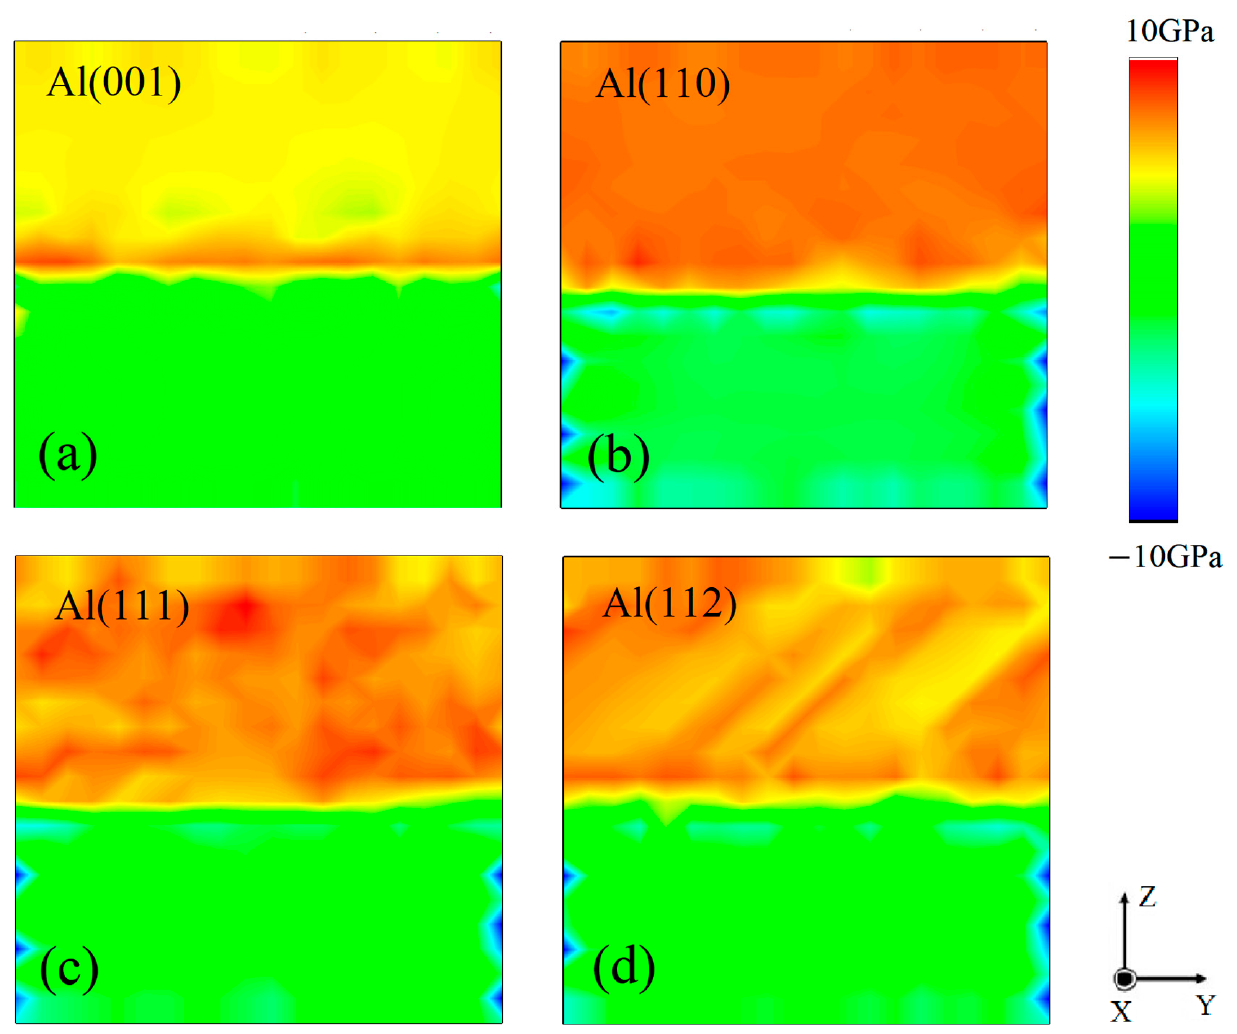
Figure 5. Stress distribution before cracks’ nucleation of four SiC(0001)-Si/Al interface systems: ( a ) SiC(0001)-Si/Al(001), ( b ) SiC(0001)-Si/Al(110), ( c ) SiC(0001)-Si/Al(111), ( d ) SiC(0001)-Si/Al(112).